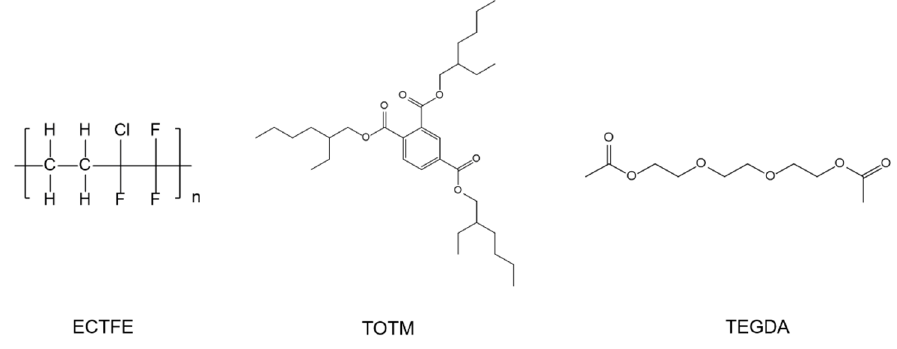
Figure 3. The molecular structure of ECTFE, TOTM and TEGDA.